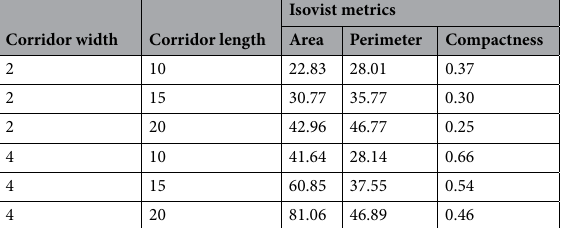
Table 1. Isovist metrics calculated for different corridor width and length combinations.